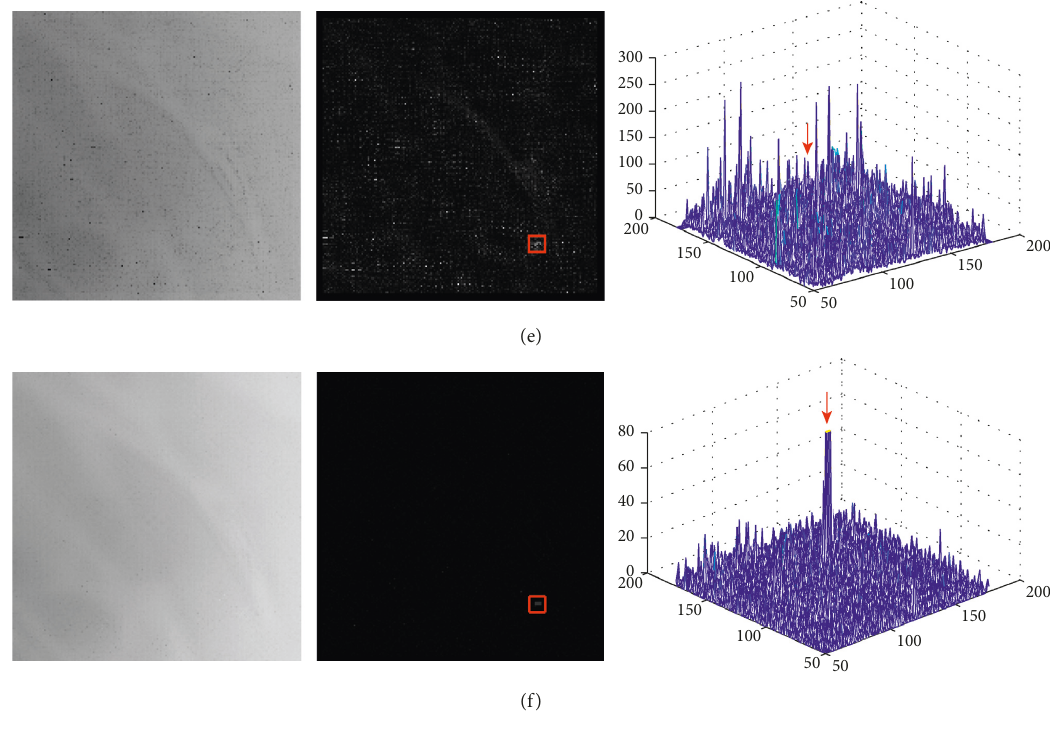
Figure 2: Background modeling results of different algorithms. Table 5: Segmentation results of different